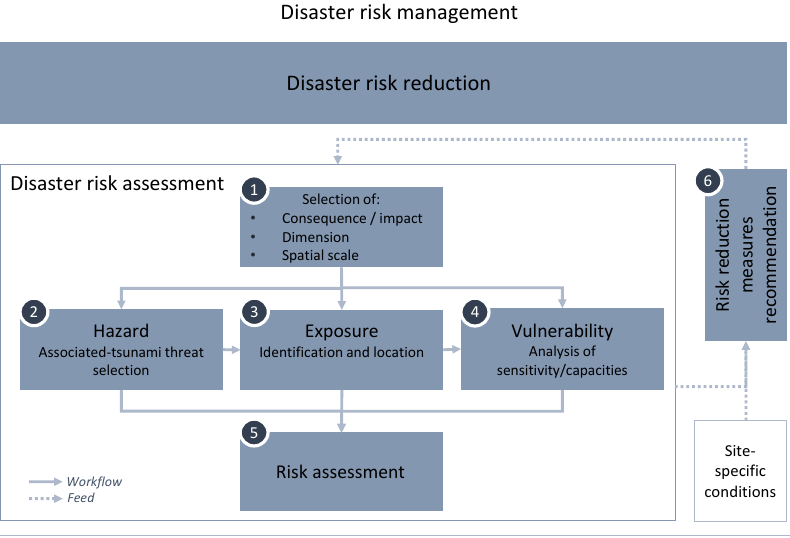
contributing to the strengthening of resilience and reduction of disaster losses (point 6 in Fig. 1. – schematic workflow, detailed in Sect.